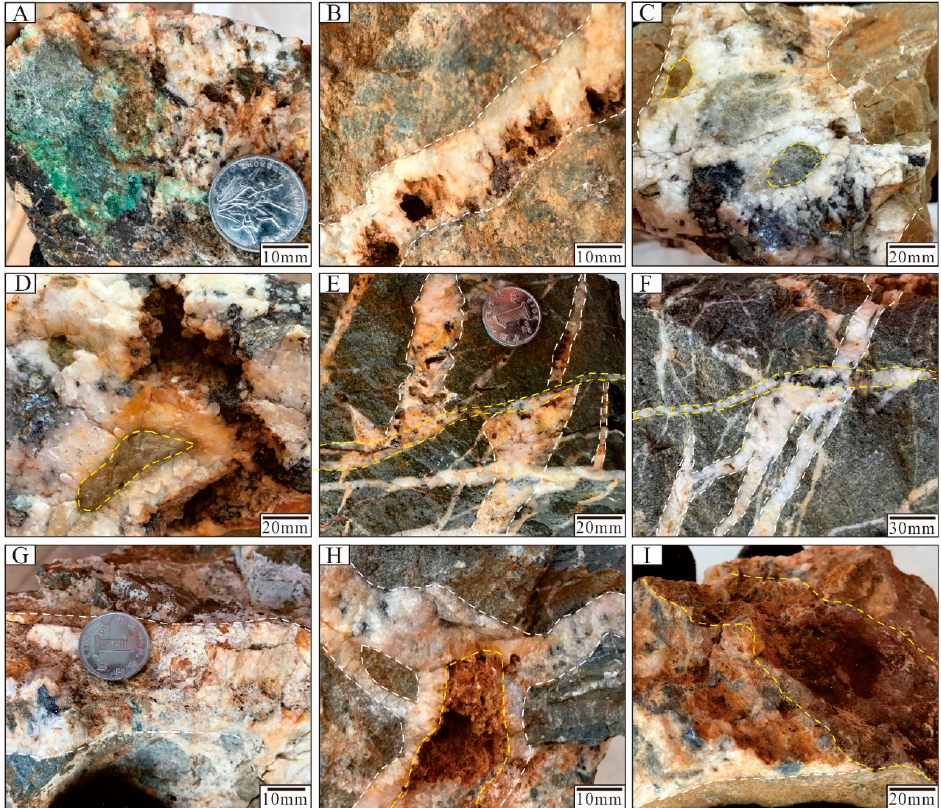
Figure 3. Photographs of ore veins from the Kuergasheng Pb–Zn deposit. ( A ) Pyrite–chalcopyrite– quartz vein with malachite; ( B ) Pyrite–chalcopyrite–quartz vein with porous structure; ( C ) Galena– sphalerite–quartz vein with wall rock breccia; ( D ) Galena–sphalerite–quartz vein with miarolitic structure; ( E , F ) Galena–sphalerite–quartz veins crosscutting pyrite–chalcopyrite–quartz veins; ( G ) Sulfide–poor–calcite–quartz veins; ( H , I ) Sulfide–poor–calcite–quartz veins crosscutting galena– sphalerite–quartz veins.